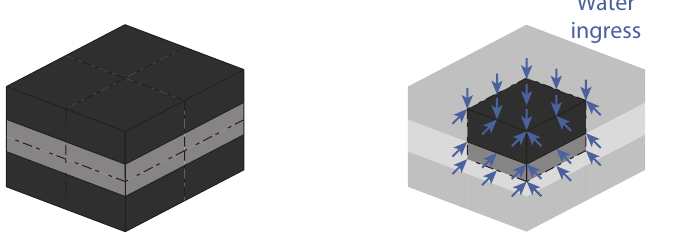
Figure 8. Numerical model developed for the gravimetric study of RJs with PBT-GF30 substrates, considering water uptake through the adhesive and